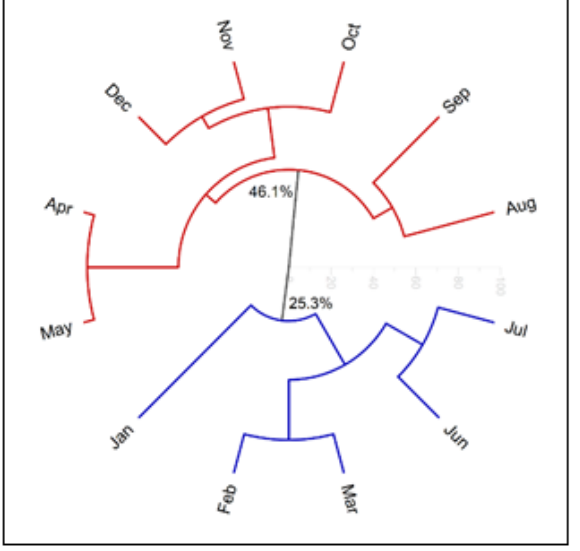
Figure 5. Hierarchical clustering analysis (HCA) based on the main constituents (above 5%) of E. patrisii essential oils.